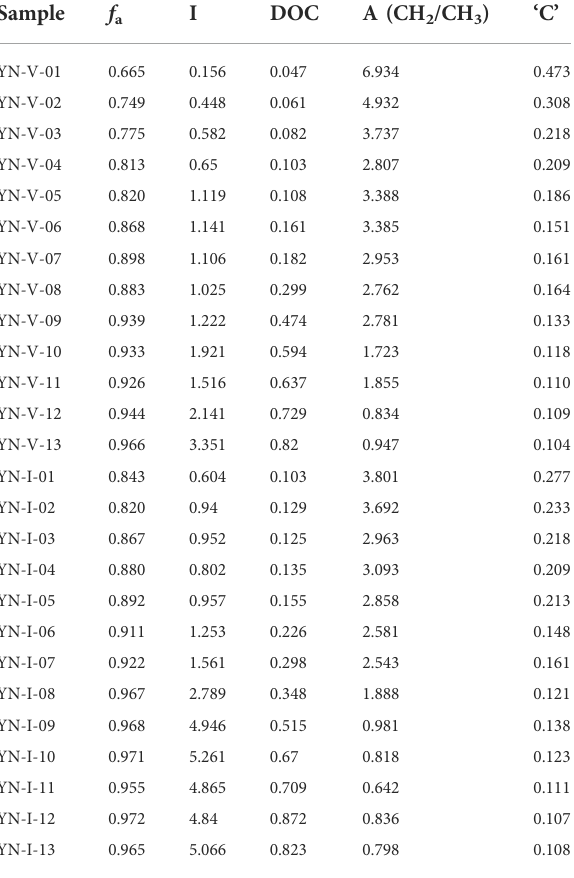
TABLE 6 FTIR parameters of thermally simulated vitrinite and inertinite samples.